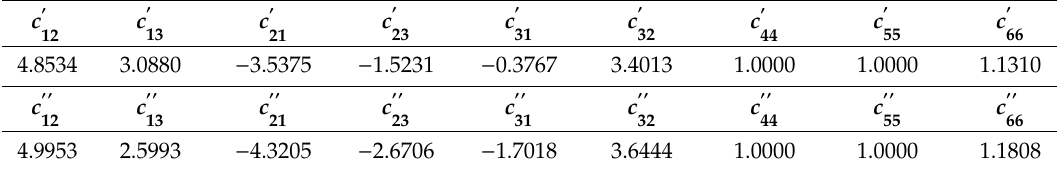
Table 2. Yield 2004-18p coe ffi cients for AA 2090-T3 sheet.